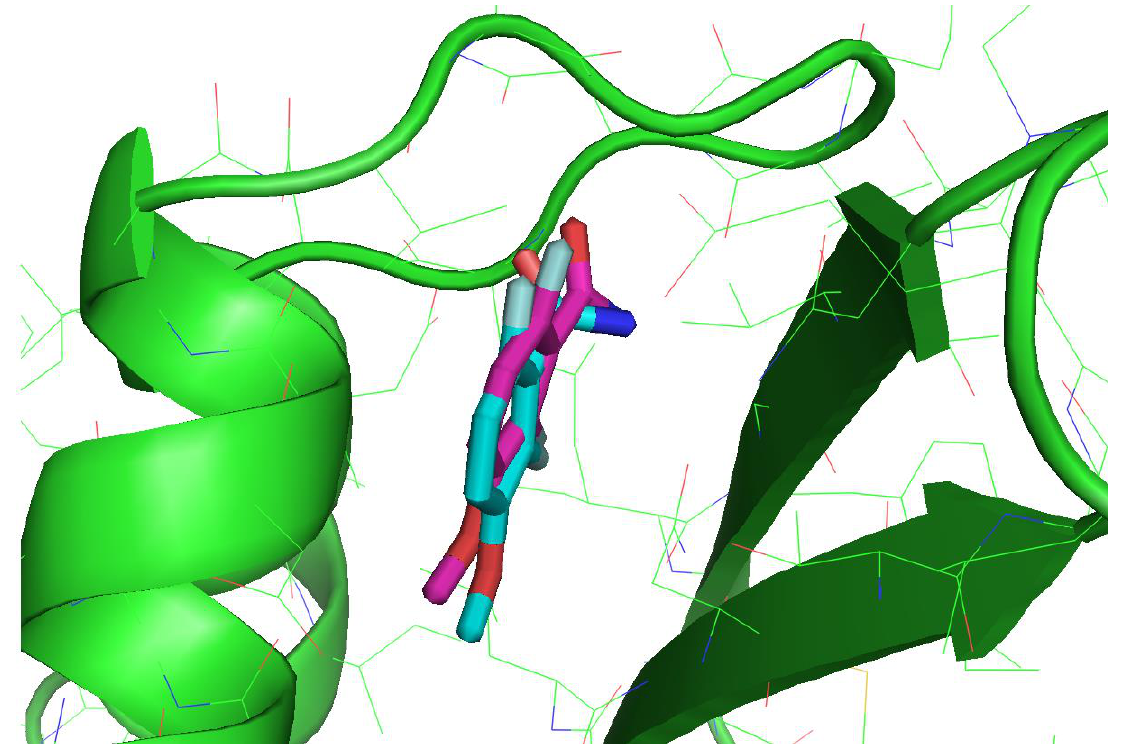
Figure 4. Binding mode of DFMBA obtained as a result of docking simulations (magenta) superim- posed with the co-crystallized ligand (cyan).